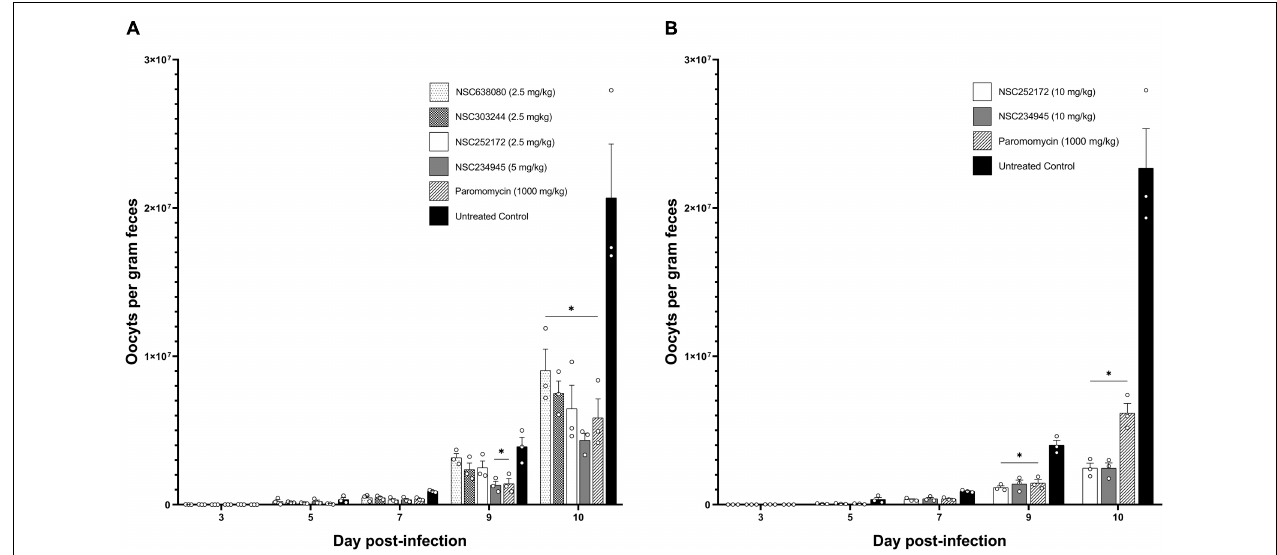
FIGURE 6 | Real-time PCR quantification of the load of C. parvum oocysts in fecal samples of infected mice treated with or without rCpPyK inhibitors. Male IFN- γ KO mice (three animals per group) were infected with 10 4 C. parvum oocysts and from the third day post-infection, daily treatment was commenced with (A) 2.5 mg/kg NSC638080, 2.5 mg/kg NSC303244, 2.5 mg/kg NSC252172, or 5 mg/kg NSC234945, and (B) 10 mg/kg NSC252172 or 10 mg/kg NSC234945. In both experiments (A,B) paromomycin at 1,000 mg/kg was used as positive control treatment, while the untreated control group of mice was administered an equivalent volume of the solvent used to reconstitute the test compounds (5% DMSO in water). Oocyst shedding per gram of feces was measured by qPCR of the C. parvum 18S rRNA gene, and the equivalent oocysts per gram feces were derived using a standard curve. The data shown represent the means for fecal oocysts load from three mice per group. Bars represent standard errors of the mean (SEM) with level of statistical significance as compared to the untreated control mice indicated by asterisk ( ∗ P <